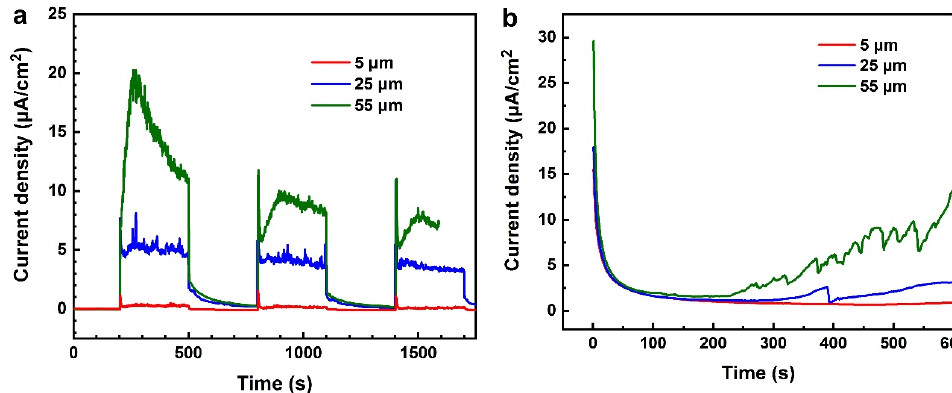
Figure 6. Potentiostatic polarization plots of 316L SS at different CE amplitudes. ( a )under alternating CE and quiescence states. ( b ) static potentiostatic polarization curves after CE for 40 min. Figure 6b shows static potentiostatic polarization curves after CE for 40 min, and the applied potential is 0 V vs. OCP. The current density with different CE amplitudes shows a rapid decrease when CE is closed, reflecting a self-repairing process of 316L SS during the quiescent state. Current density maintains a stable value of 0.75 μ A/cm 2 after CE with 5 μ m amplitude, implying that low CE amplitudes have little effects on the protection of passive films. In contrast, current densities with CE amplitudes of 25 μ m and 55 μ m are about 2.95 μ A/cm 2 and 10.13 μ A/cm 2 , respectively, after 600 s’ test, which reflects weak repassivation ability. Taken together, repassivation properties of 316L SS gradually weaken with increased cavitation intensity.